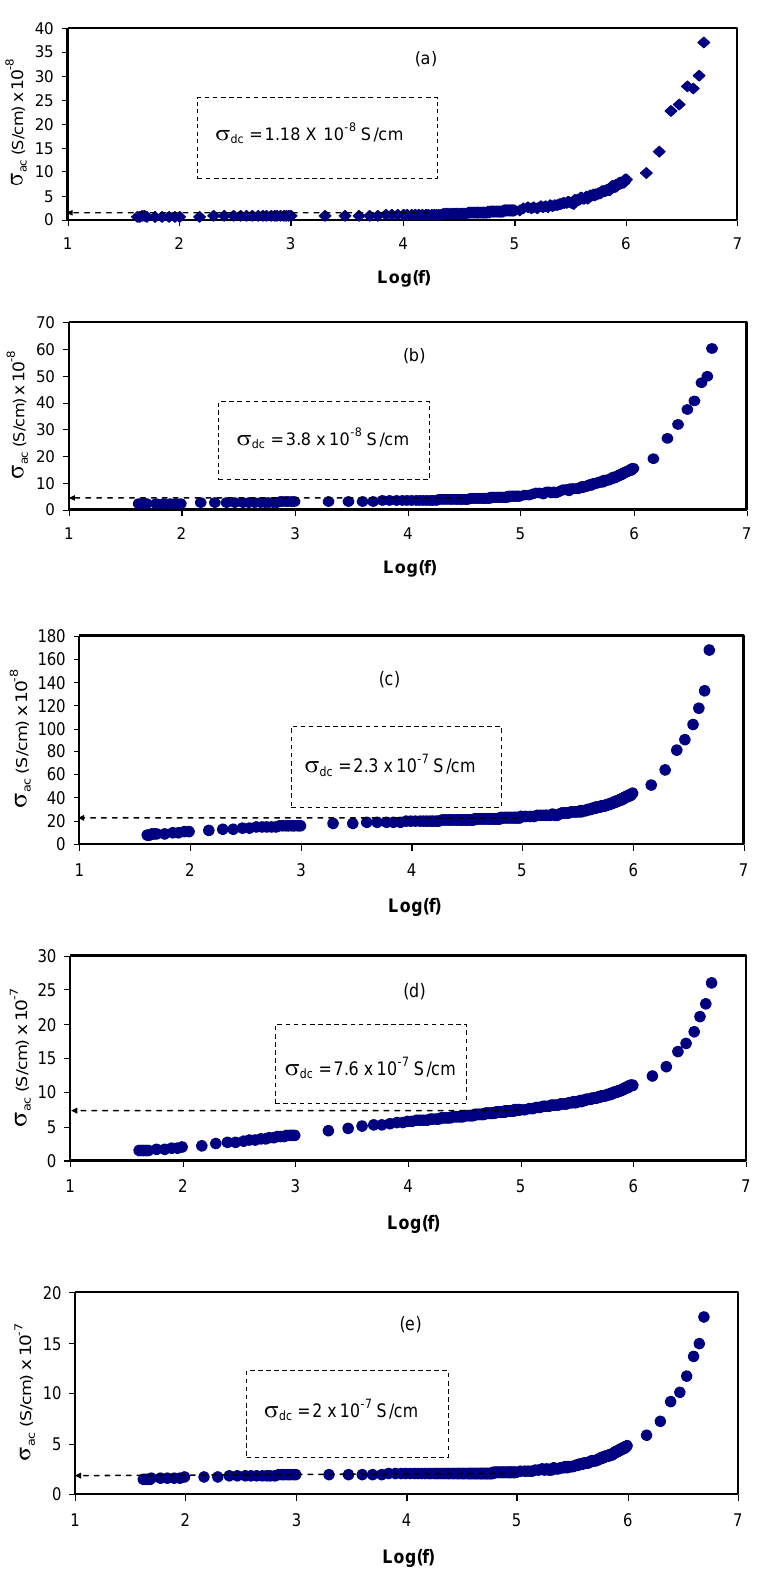
Figure 7. AC conductivity spectra for ( a ) PVCS 1, ( b ) PVCS 2, ( c ) PVCS 3, ( d ) PVCS 4 and ( e ) PVCS